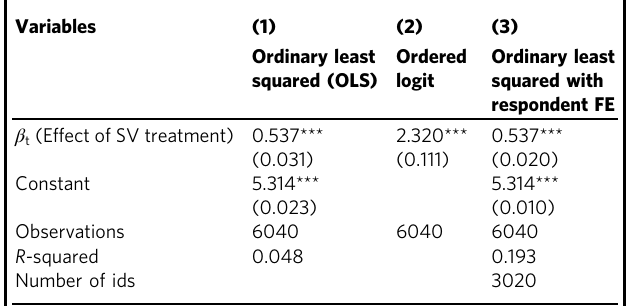
Table 1 Effect of information treatment on support for hydrogen for all